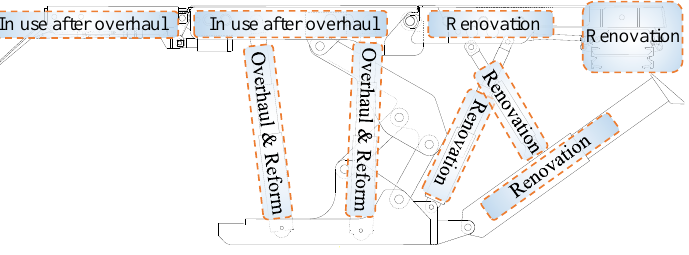
Figure 7. Reconstruction position of hydraulic supports.